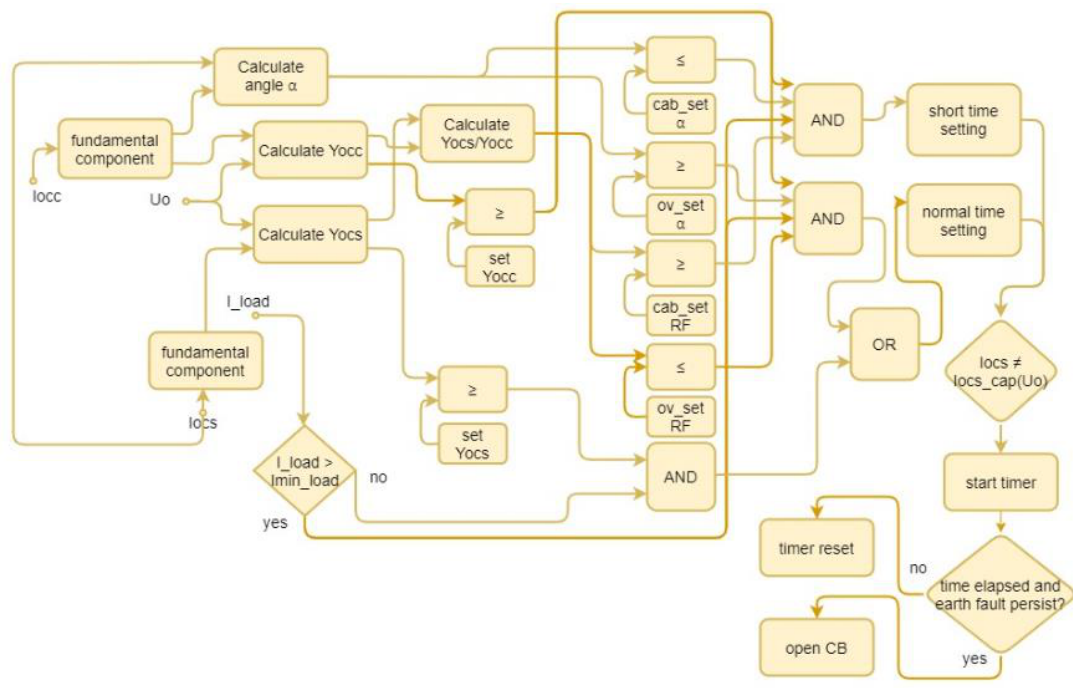
Figure 20. An algorithm for fault detection and identification of line type affected by earth fault.